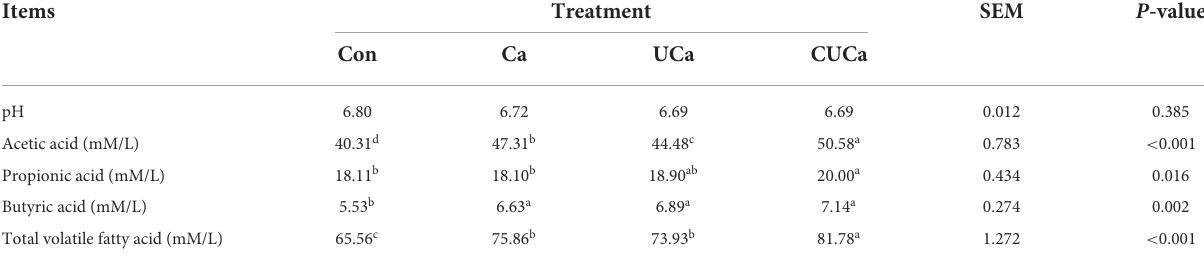
TABLE 4 Effect of CSL plus urea-alkali pretreatment on in vitro rumen fermentation parameters of rice straw.